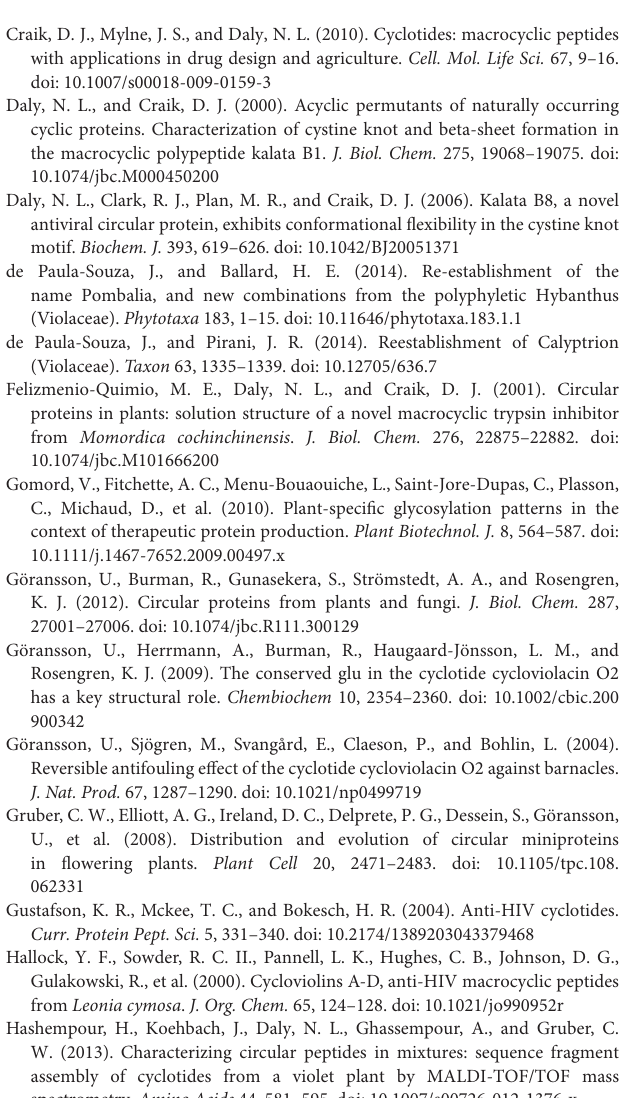
Supplementary Figure 2 | Sugar analyses using HPLC and electrochemical detection demonstrating that glucose is released after chemical